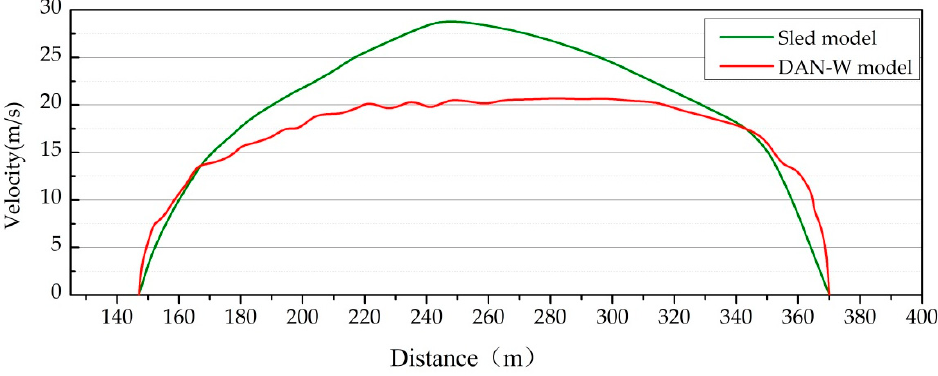
Figure 12. Speed contrast diagram of two models of the Panjinbulake landslide.